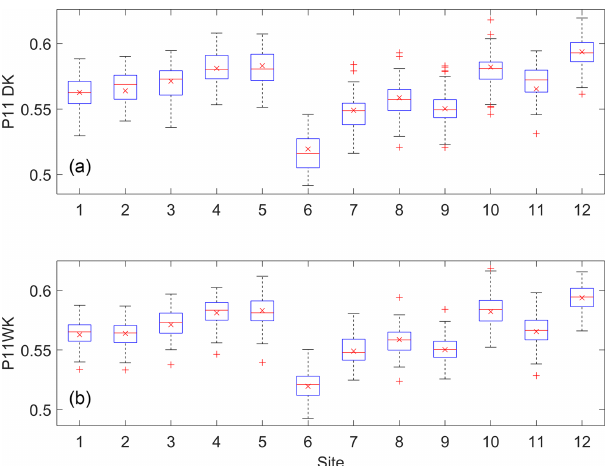
Figure 5. Box plots of the P 11 probability for the simulated data from the DKNNR model (a) and the MONR model (b) , as well as the observed ( x marker) for the 12 selected weather stations from the Yeongnam province.